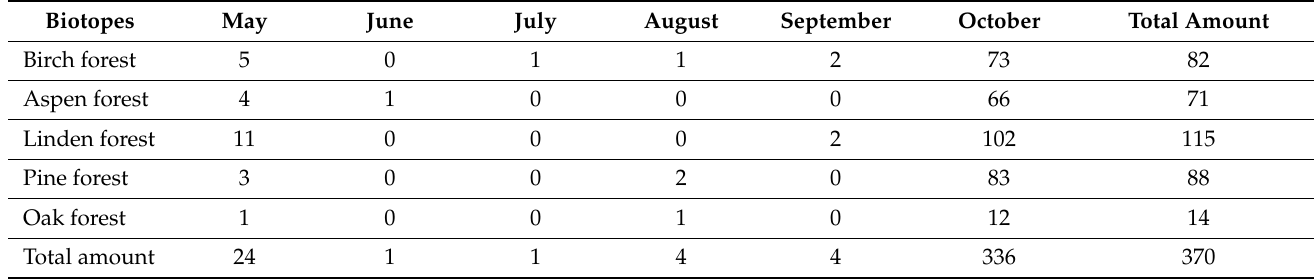
Table A4. Seasonal dynamics of Drosophila testacea in five biotopes.